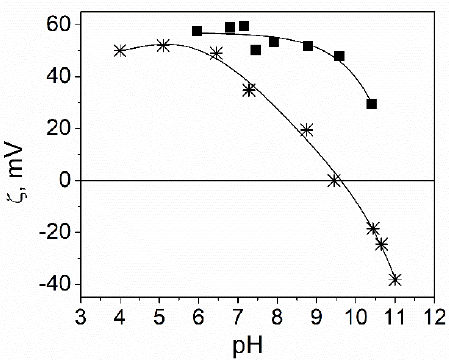
Figure 2. pH dependence of electrokinetic potential of CuO nanoparticles without (*) and with PEI ( ■ ).